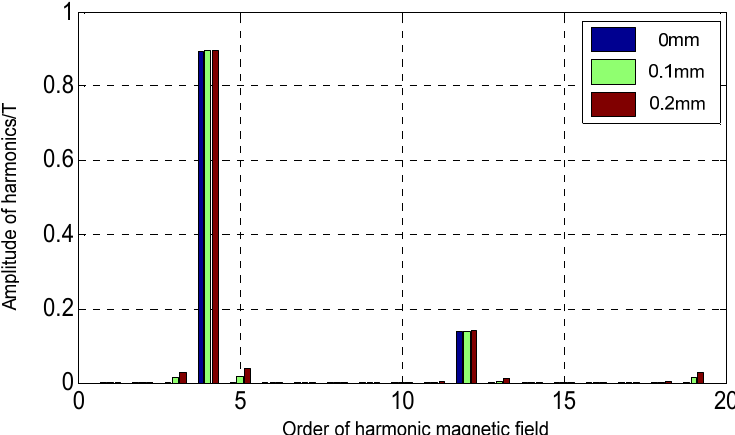
Figure 9. Comparison of harmonic components of normal magnetic density of air gap in the whole circumference.